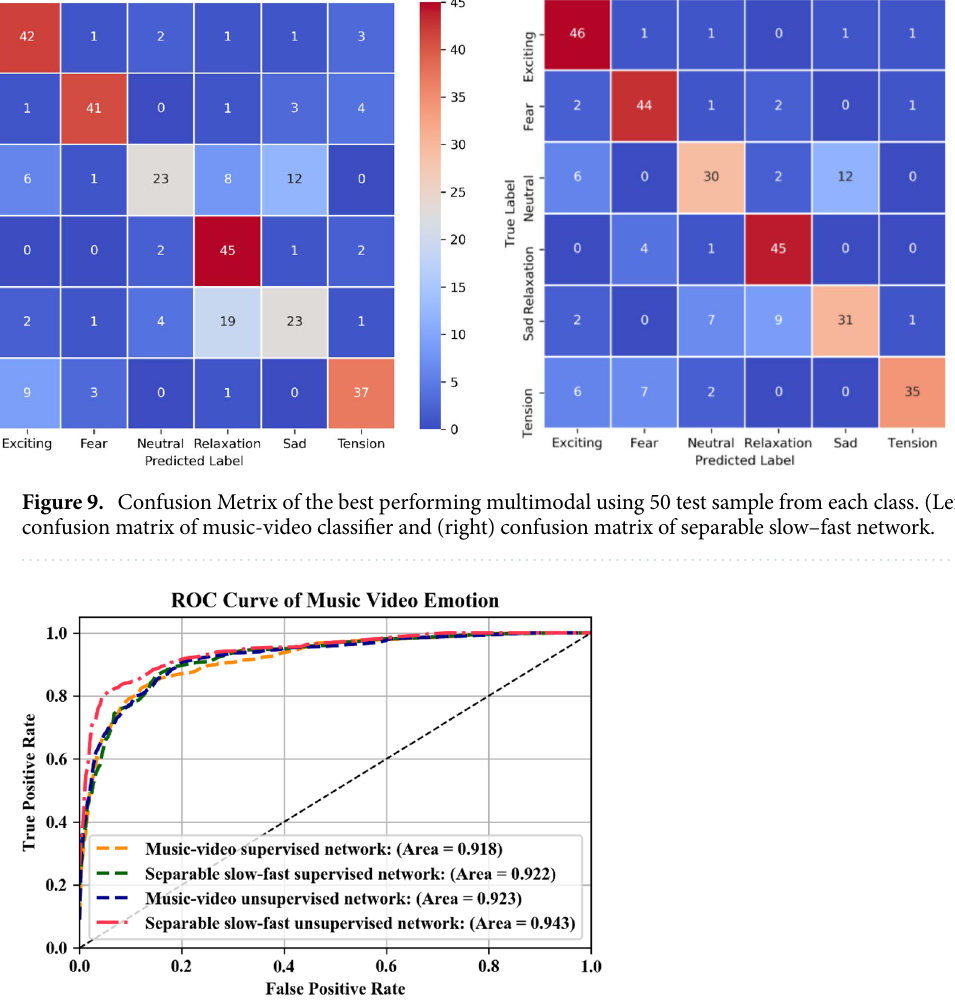
Figure 10. The ROC curve using several multimodal architectures trained on labelled and unlabeled